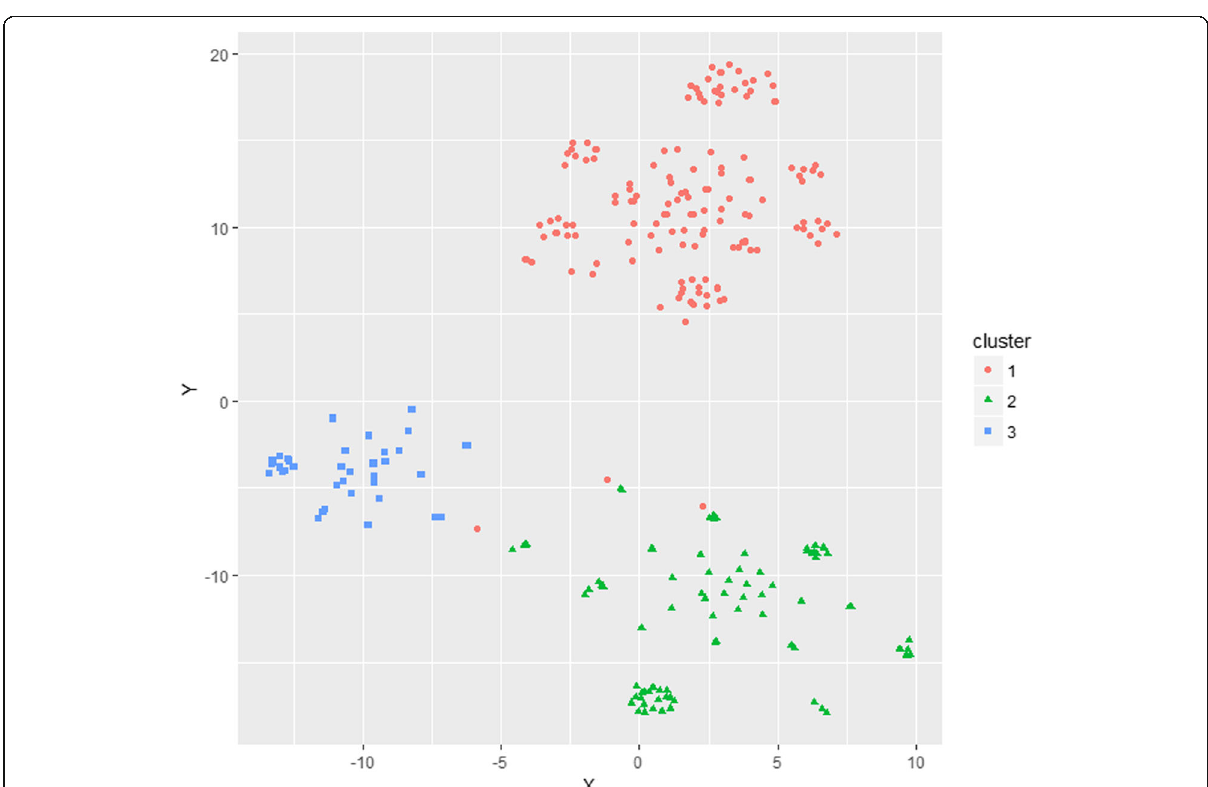
Fig. 7 Illustration of bibliographic source